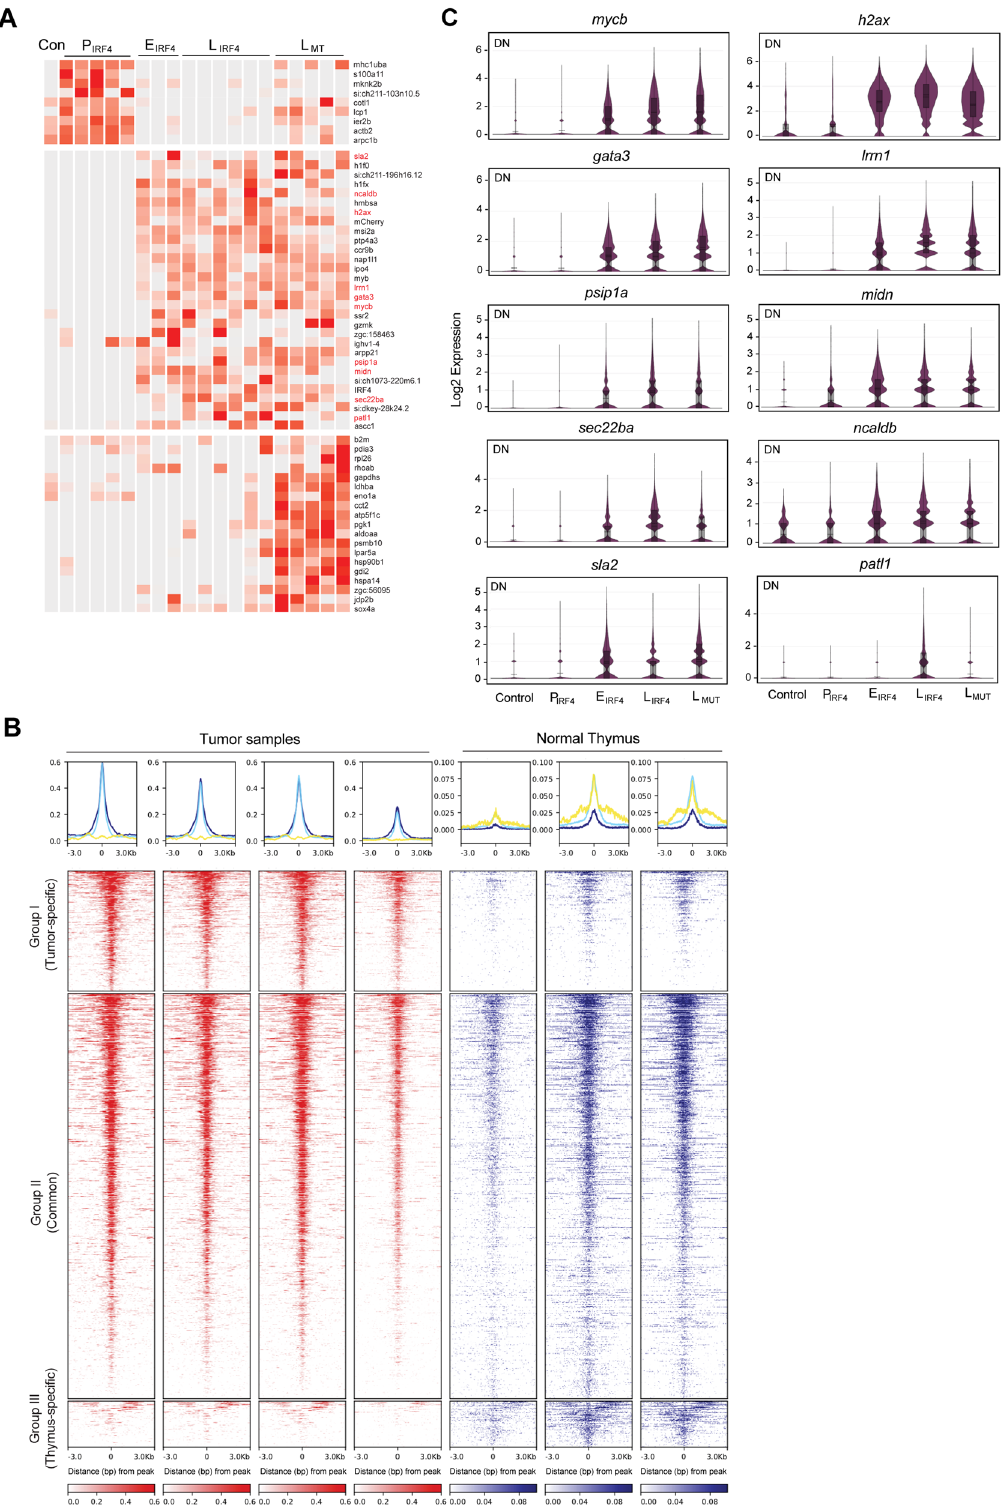
expression and differential epigenetic analyses (Fig. 5A, middle; Fig. 5C; Supplementary Fig. 5B). In particular, expression of lrrn1, patl1 and psip1a were highly speci fi c to tumor cells; 0% of normal thymus and less than 3% preleukemic samples were positive for all three genes, while up to 46% of tumor samples were positive (Supplementary Fig. 5F). The orthologues of fi ve genes, LRRN1, PSIP1, PATL, H2AFX , and MIDN , were signi fi cantly upregulated